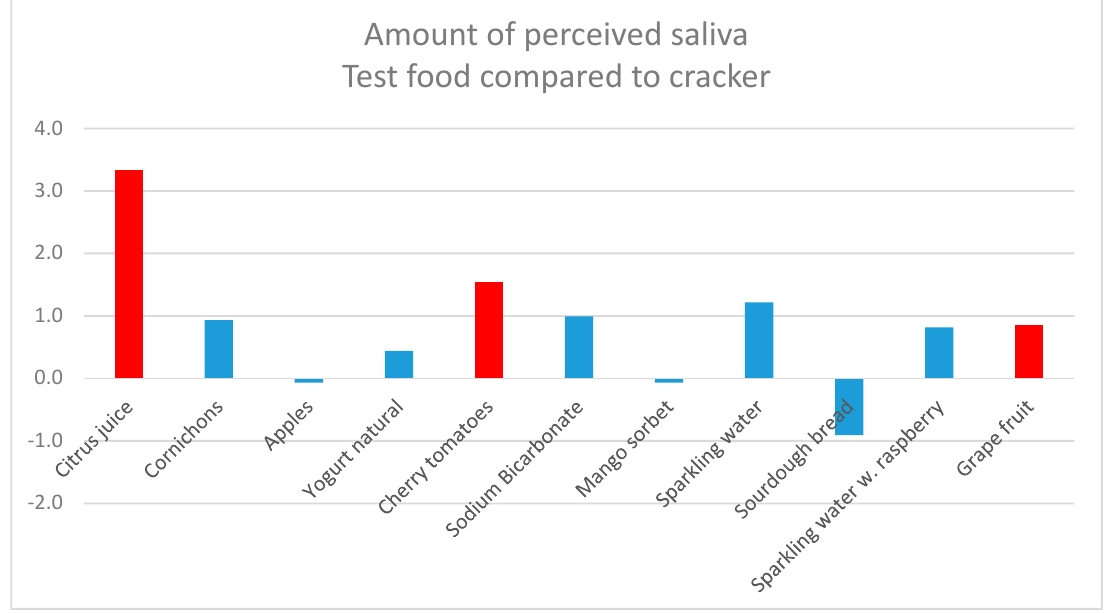
Figure 3. Perceived amount of saliva for test foods compared to the baseline cracker. The red bars indicate a significant difference from the baseline, p ≤ 0.05. The perceived amount of saliva did not correlate with ease of swallowing.